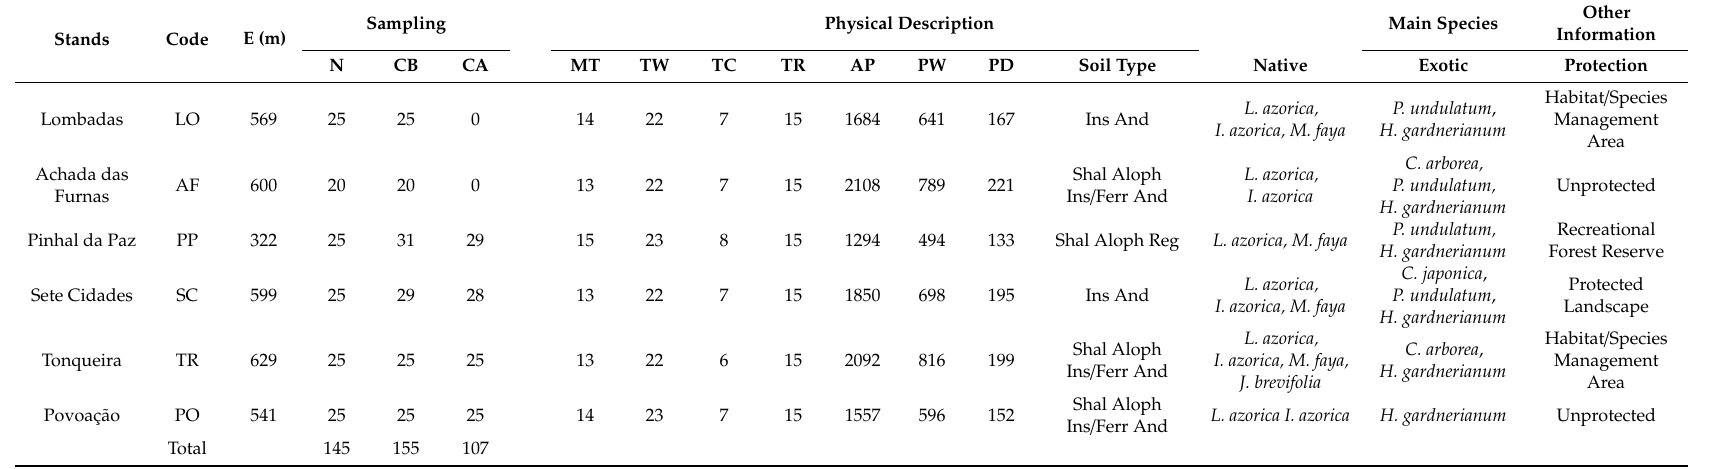
Table 1. Characterization of the sampling stands of Laurus azorica (Seub.) Franco trees in S ã o Miguel Island. Elevation (E, m), number of trees (N), number of cores at breast or at the base (CB, CA), Annual Mean Temperature (MT, ◦ C), Maximum Temperature of the Warmest Month (TW, ◦ C), Minimum Temperature of the Coldest Month (TC, ◦ C), Annual Temperature Range (TR, ◦ C), Annual Precipitation (AP, mm), Precipitation of the Wettest Quarter (PW, mm), Precipitation of the Driest Quarter (PD, mm). Soil Types: Ins—Insaturated; Ferr—Ferruginous; Shal Aloph—Shallow Alophanic soil; Reg—Regosoil. Climatic data from Karger et al. [35] and Soil data from Ricardo et al. [36]. Native and exotic species as mentioned in the